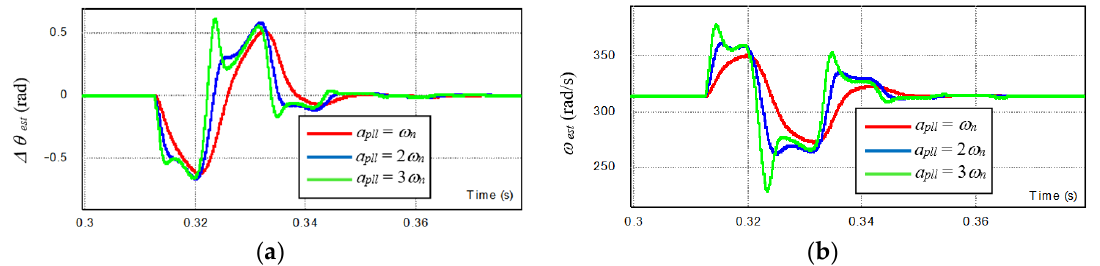
Figure 12. The estimated phase angle error ( a ) Δ θ est and estimated frequency ( b ) ω est for three different a pll values, for the DC offset introduced at the FFPLL input.